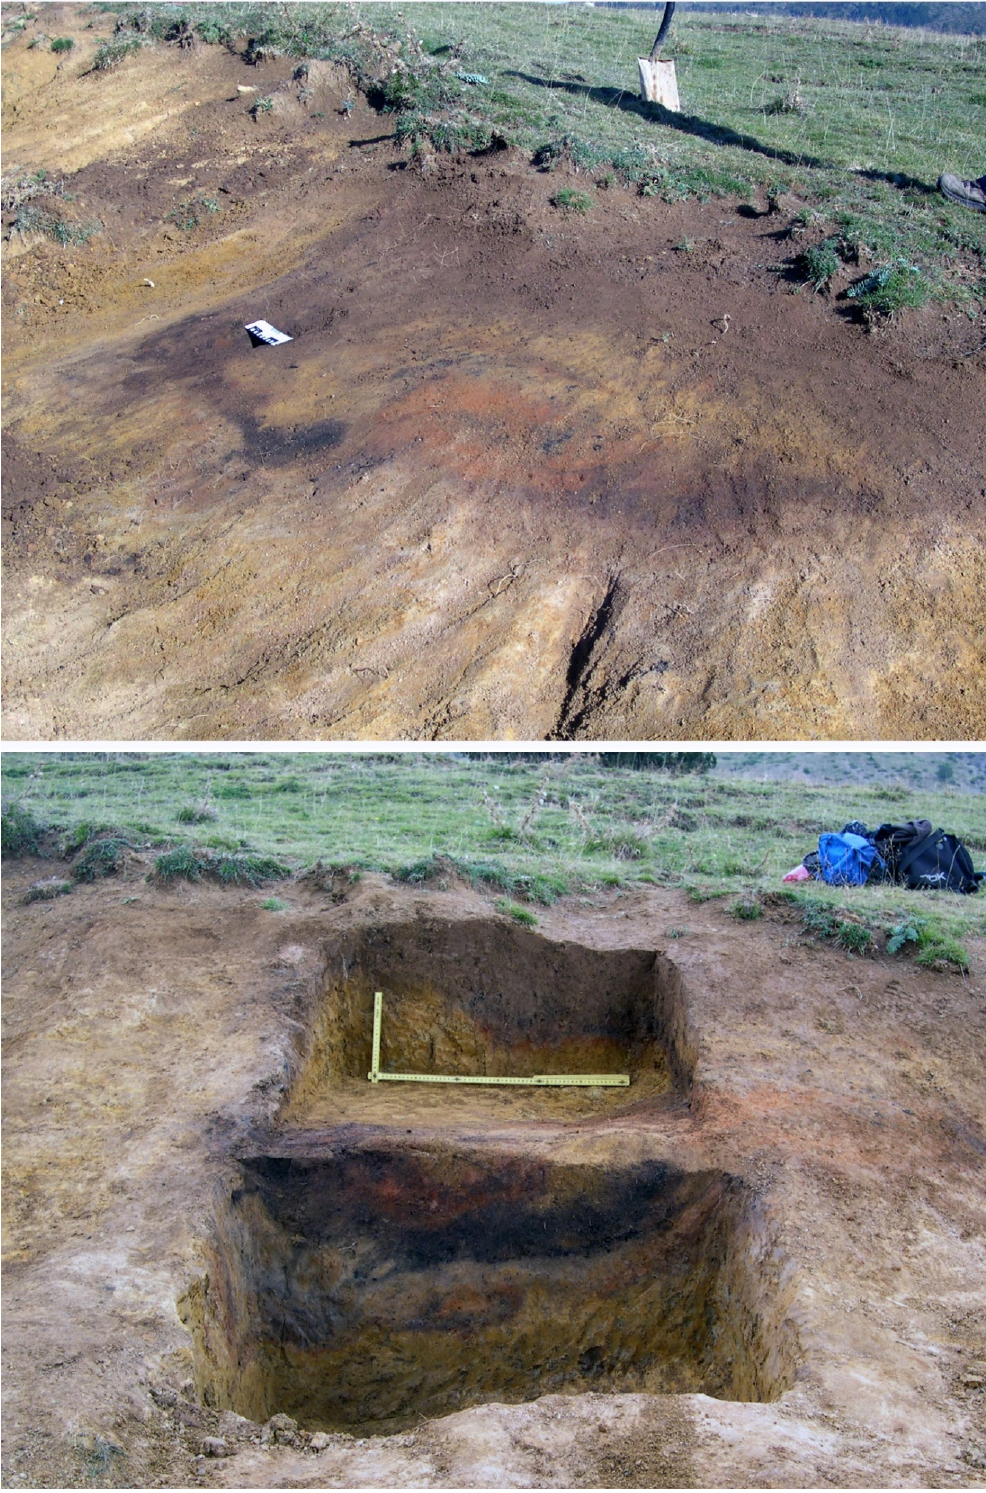
Figure 25. Historical Camp (HC): the excavation carried out at pine tree-pit HC-5 which was radiocarbon-dated to 2485 ± 30 BP (GrA-59654) (photographs by P. Biagi, 2010).